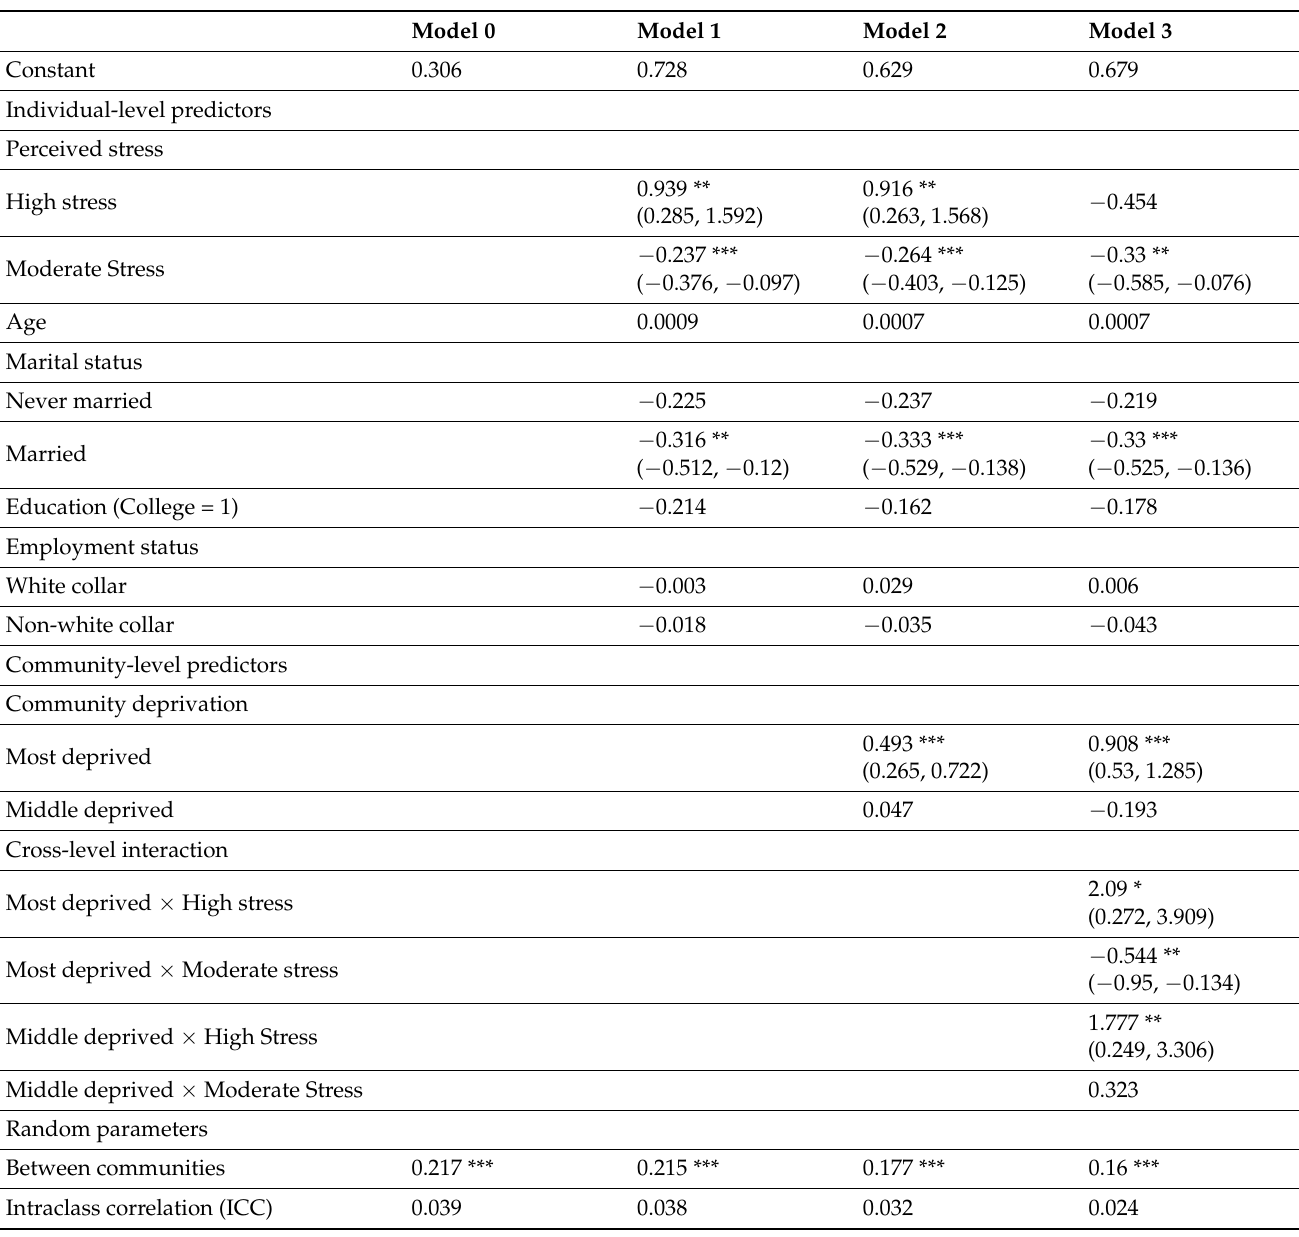
Table 4. Fixed and random part results for the multilevel regression models of female respondents, restricted to ages over 21, CHNS,